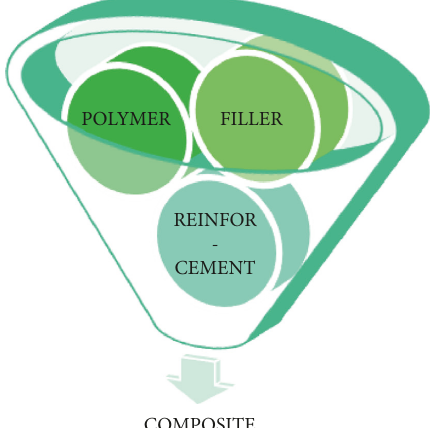
Figure 2: Polymer composite